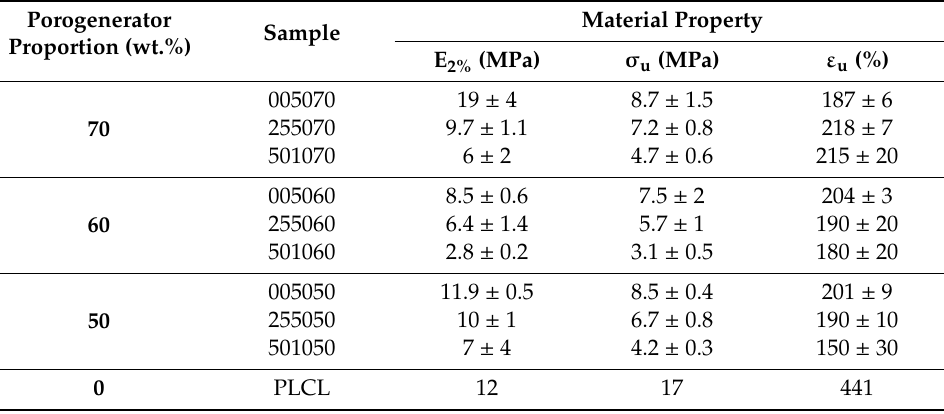
Table 3. Secant modulus E 2% (MPa), ultimate strength σ u (MPa) and elongation at break ε u (%), measured by tensile tests, of porous sca ff olds produced using 50, 60 and 70 wt.% of porogenerator and particle sizes in 0–50, 25–50 and 50–100 µ m size ranges, and compared to neat PLCL.